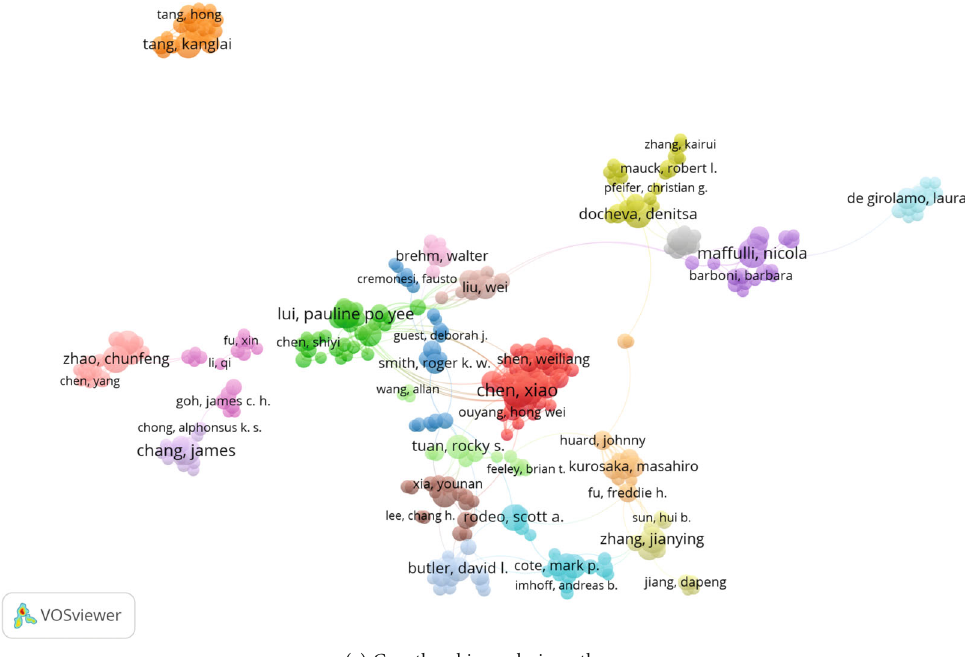
Figure 4: Coauthorship analysis of global research of tendon stem cells. (a) Mapping on the 32 identi fi ed countries by co-authorship analysis in this fi eld. (b) Mapping on the 265 identi fi ed institutions by coauthorship analysis in this fi eld. (c) Mapping on the 378 identi fi ed authors by coauthorship analysis on the research of stem cells for